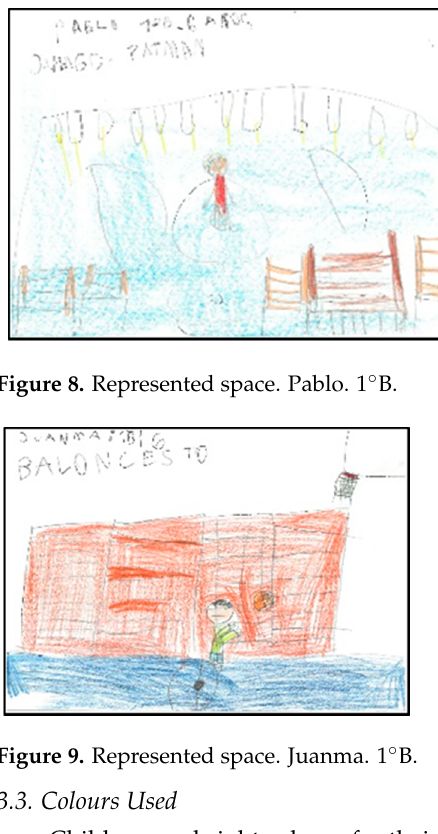
Figure 7. Represented space. Daniela. 2°B.